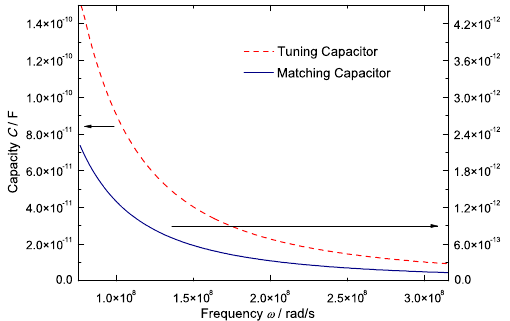
Figure 2. Basic structure of the NQR sensor.